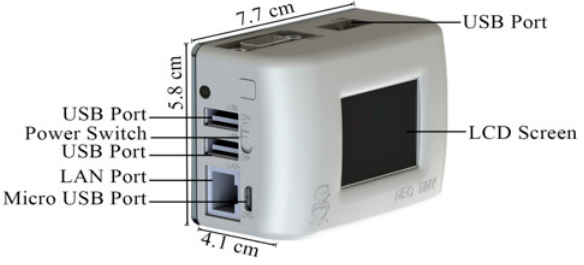
Figure A3. Physical image of NTS client.